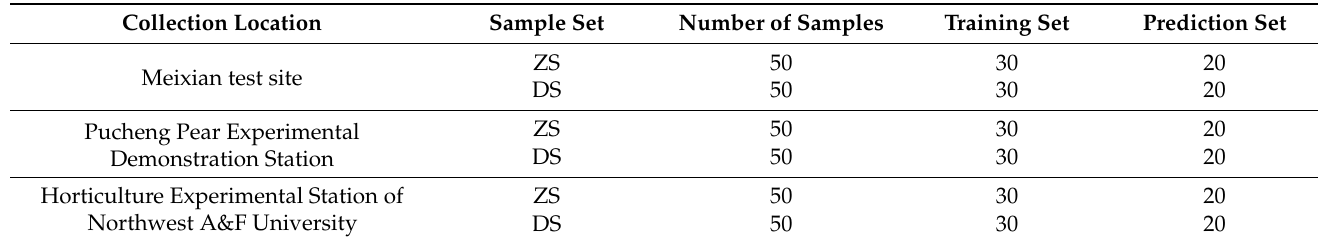
Table 3. Sample selection